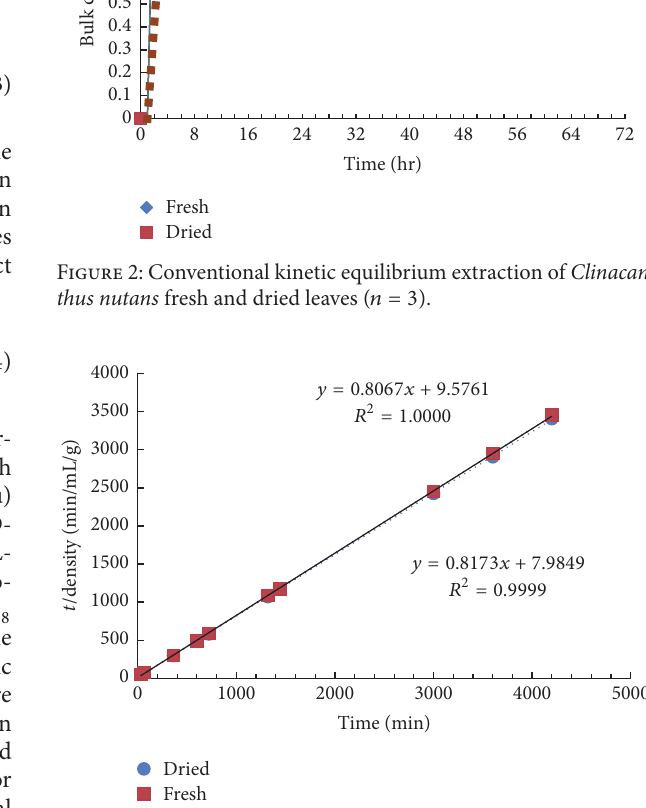
Figure 3: Peleg model kinetic regression line of Clinacanthus nutans fresh and dried leaves water extract ( 𝑛 = 3